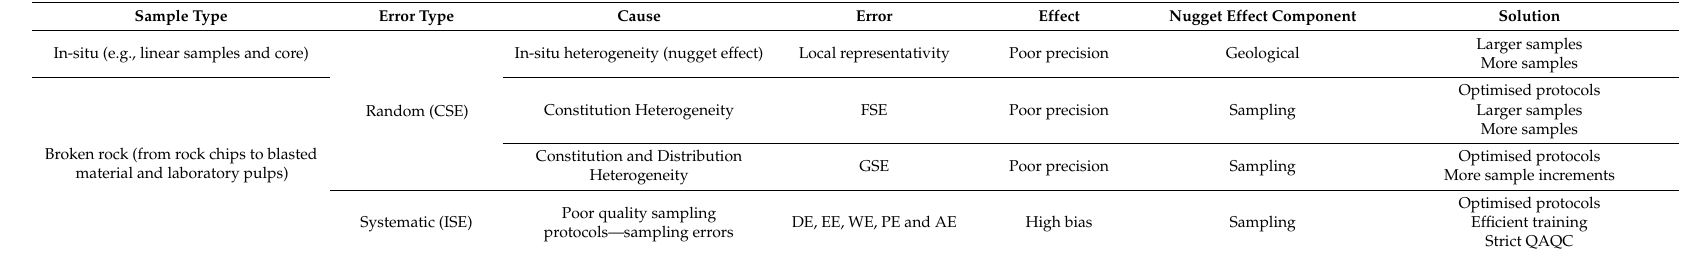
Table 4. Cause, effect and solutions to TOS